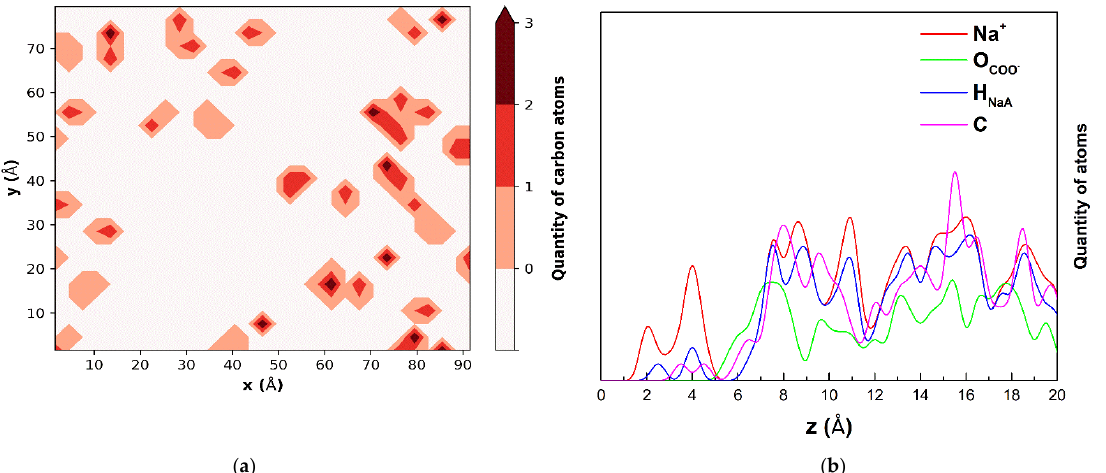
Figure 4. ( a ) Carbon quantity contour maps on the xy-plane parallel to the montmorillonite layer and ( b ) the quantity of Na + , O COOH , H NaA (H in sodium acrylate), and C as a function of distance from the montmorillonite layer surface for 36.35, 52.90, and 63.00 ps after adding sodium